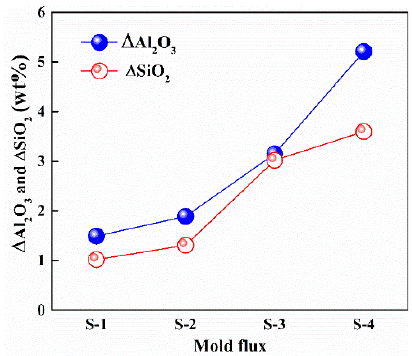
Figure 3. Variations of Al 2 O 3 and SiO 2 before and after steel–slag reaction. Table 5. Composition of mold flux before and after steel–slag reaction (wt%).